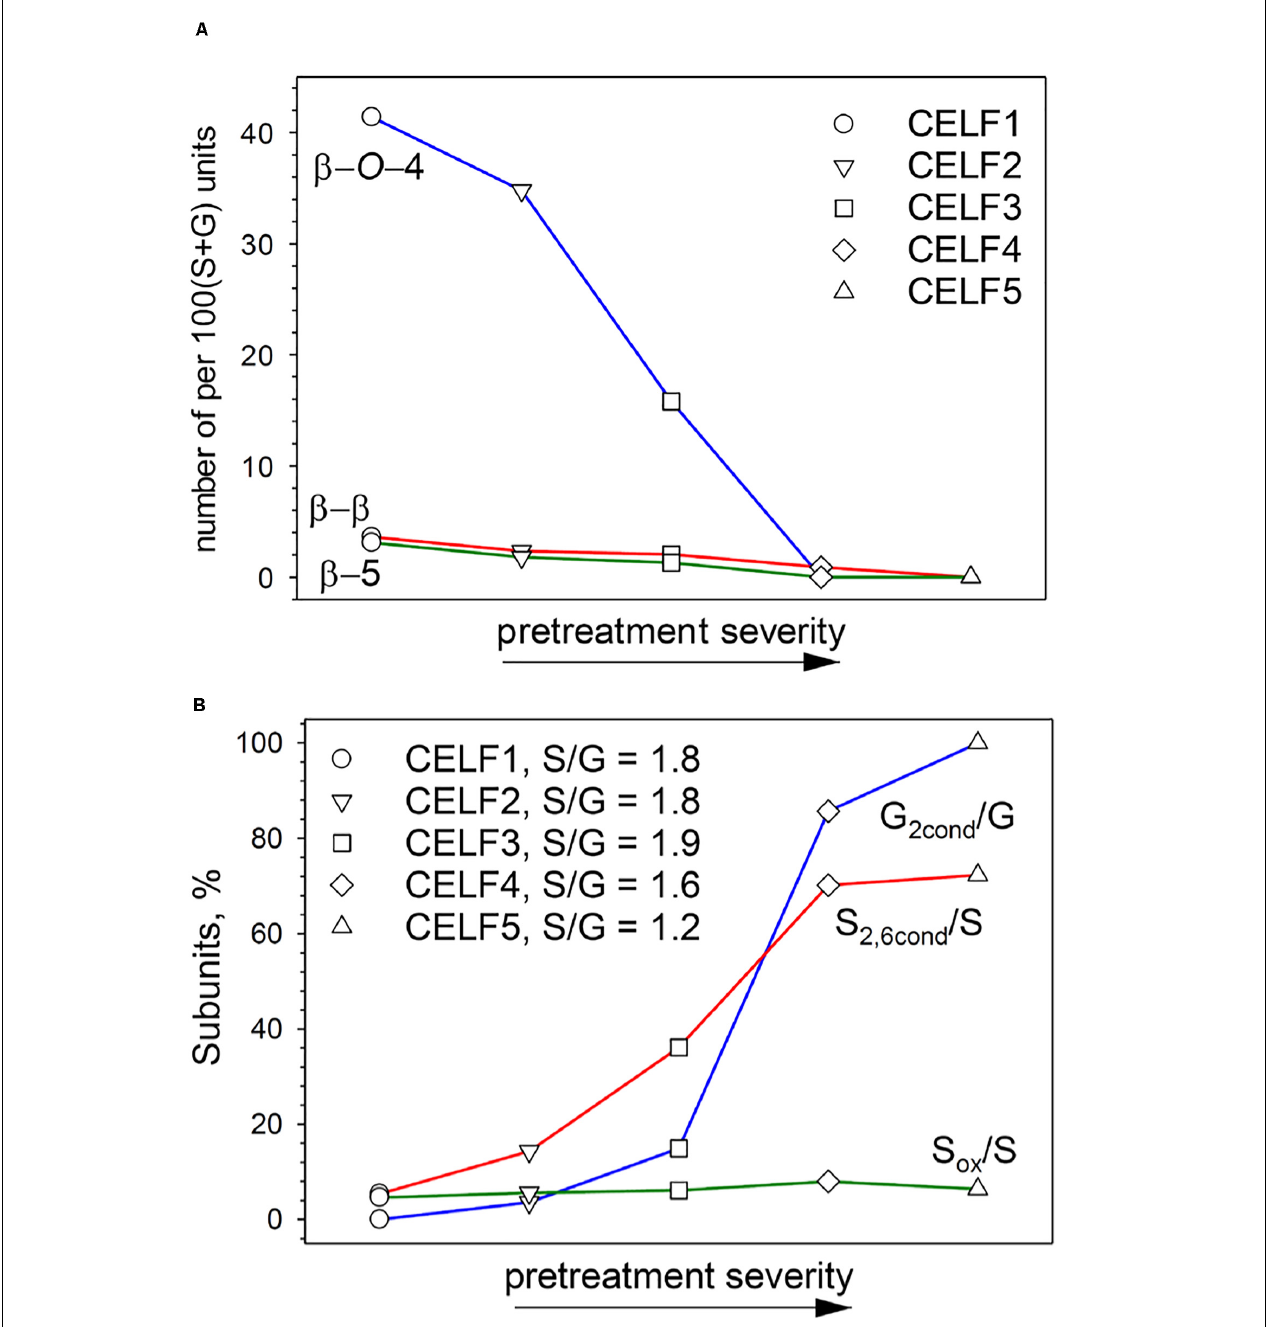
FIGURE 4 | Semiquantitative HSQC analyses of CELF lignin interunit linkages and subunits. (A) Changes of β –O–4 (cid:48) , β – β (cid:48) and β –5 (cid:48) interunit linkage contents [per 100 (S + G) units] with increasing pretreatment severity; (B) Changes of condensed guaiacyl (G 2 cond ), condensed syringyl (S 2 , 6 cond ) and oxidized syringyl (S ox ) subunit contents with increasing pretreatment